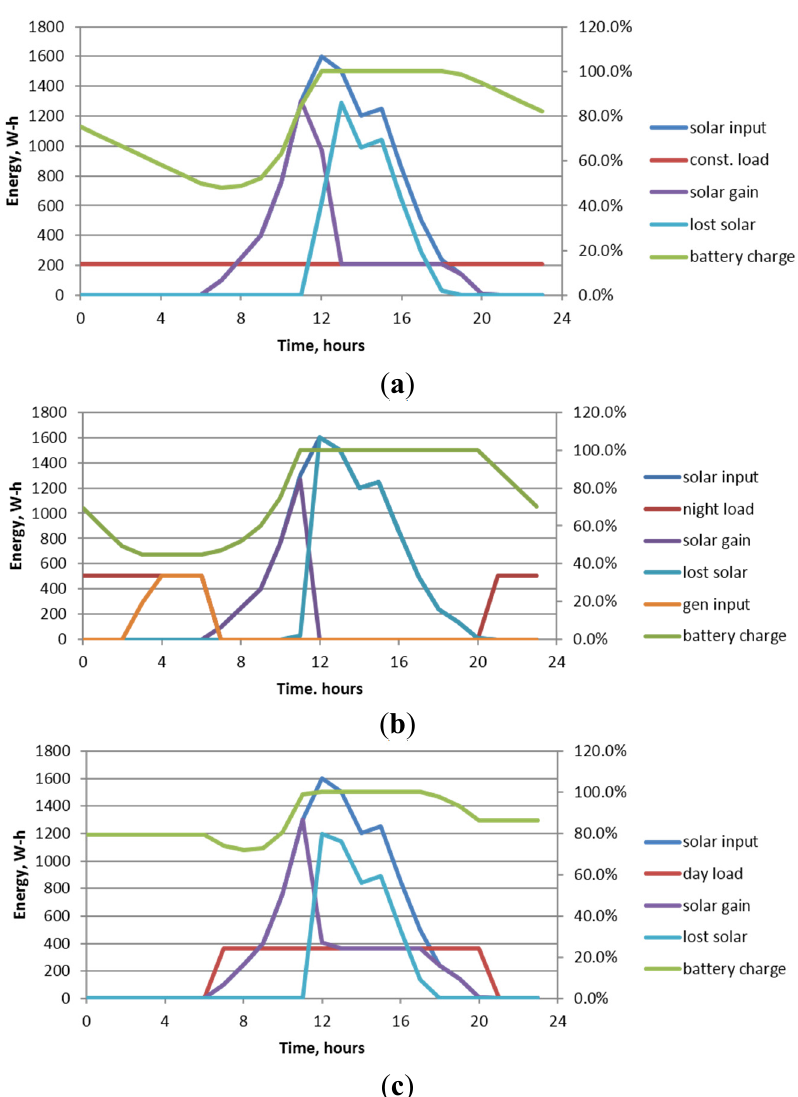
Figure 4. ( a ) Energy flows and state of battery bank charge for sunny day with constant electrical load over 24 hours with double the solar input; ( b ) Energy flows and state of battery bank charge for sunny day with constant electrical load concentrated during nighttime hours with double the solar input; ( c ) Energy flows and state of battery bank charge for sunny day with constant electrical load concentrated during daylight hours with double the solar